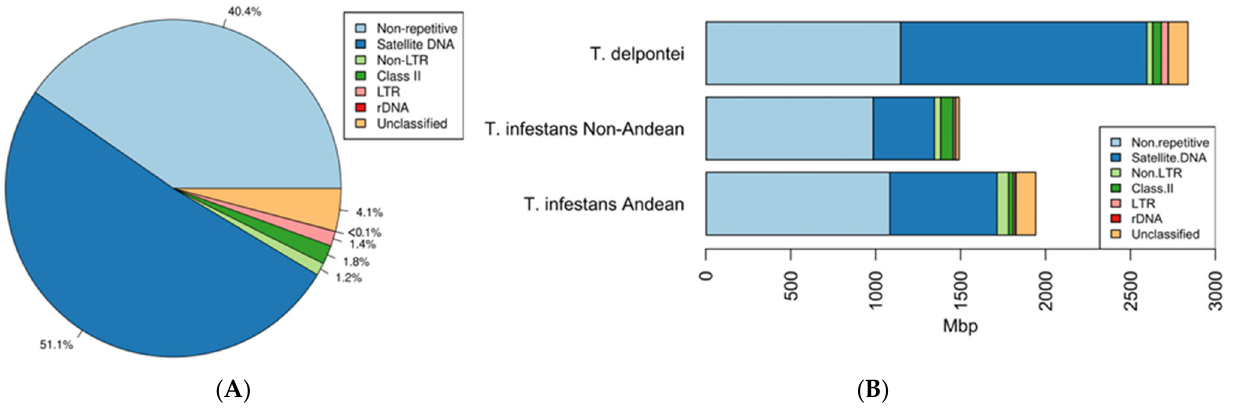
Figure 1. ( A ) T. delpontei genome composition. Percentages were calculated according to RepeatEx- plorer2 results. ( B ) Comparative chart with the composition between T. delpontei and both T.a infestans lineages genomes. All values were calculated according to RepeatExplorer2 results. The T. infestans data were taken from Pita et al. [26].